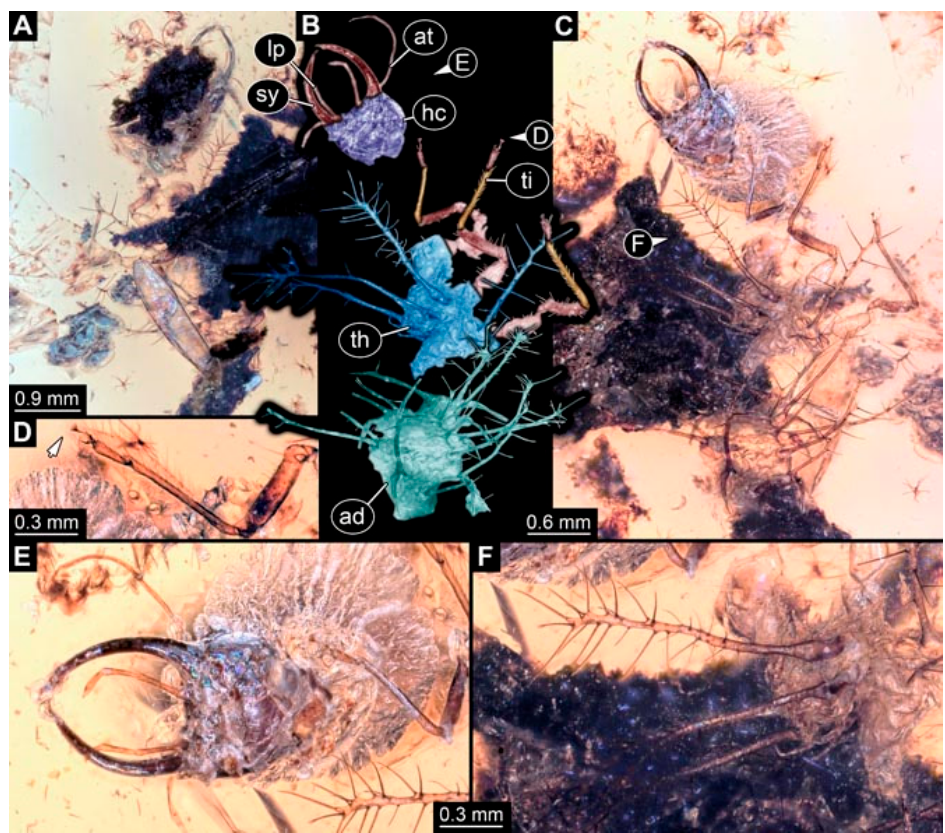
Figure 4. Specimen 4823 (BUB 3358); Myanmar amber. ( A ) Dorsal view. ( B ) Ventral view, colour- marked. ( C ) Ventral view. ( D ) Close-up of trunk appendage with empodium (arrow). ( E ) Close-up of head capsule in ventral view. ( F ) Close-up of protrusion in ventral view. Abbreviations: ad = abdomen; at = antenna; hc = head capsule; lp = labial palp; sy = stylet; th = thorax; ti = tibia.